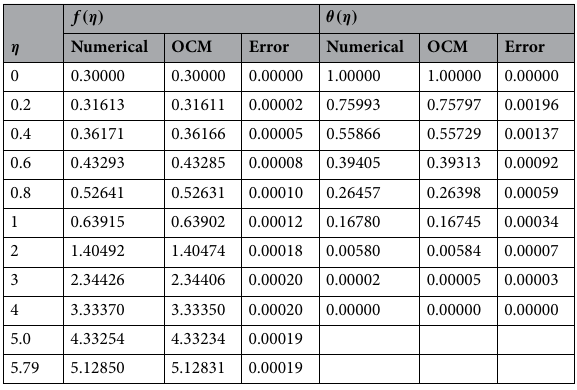
Table 4. Comparison between the optimal collocation method and Runge–Kutta method when α